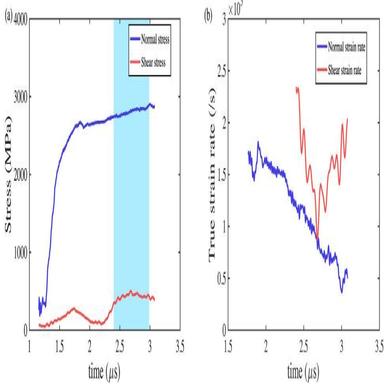
(a) The stress histories on the interface between the granular specimen and the back plate by shifting the waves from the back surface of the target assembly to the interface; the blue region indicates a stable flowing region with combination of both normal and shear; (b) strain rate histories under the assumption of homogeneous stress fields. (For interpretation of the references to color in this figure legend, the reader is referred to the web version of this article.)